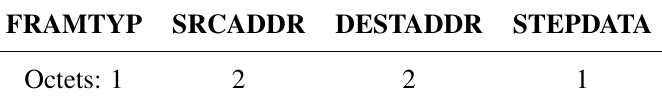
Table 3. Data frame format.